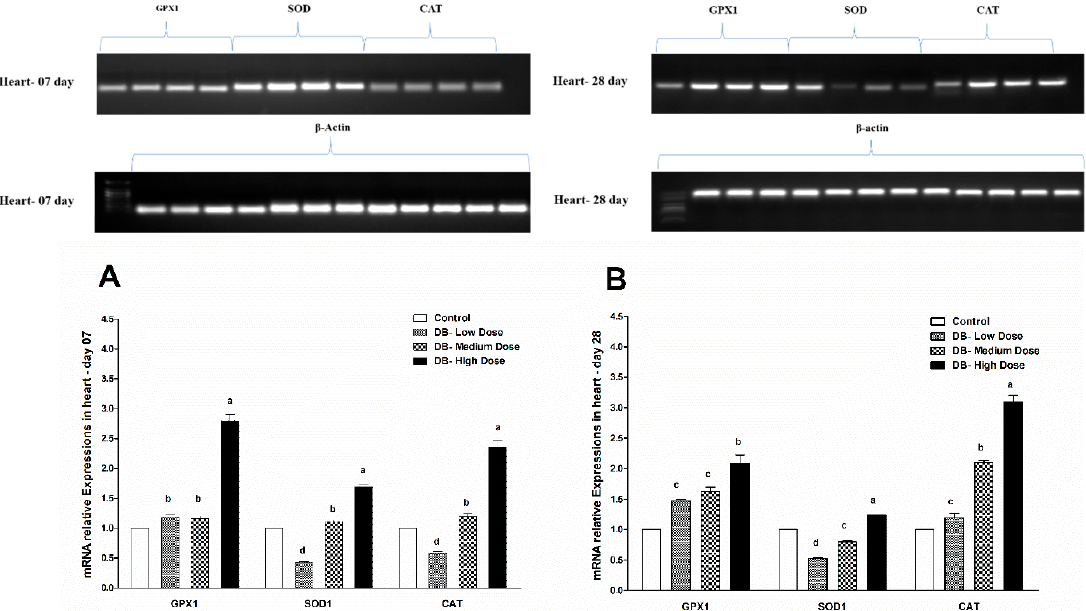
Figure 11. E ff ects of DB supplementation on heart mRNA expressions of antioxidant-related genes at 07 days ( A ) and 28 days ( B ) of age. Data are presented as mean value ± SEM (n = 6). Values without the same mark (a–d) represent statistically significant di ff erences ( p < 0.05). GPX1, glutathione